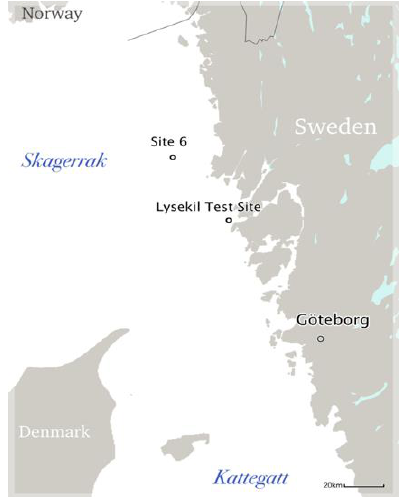
Figure 2. A scatter matrix of the annual occurrence for the sea states at Site 6. Numbers give average occurrence in hours per year.